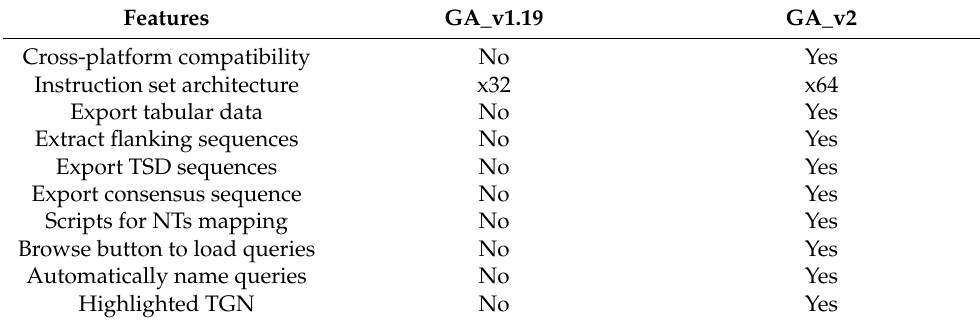
Table 1. The new features of GA_v2, compared with